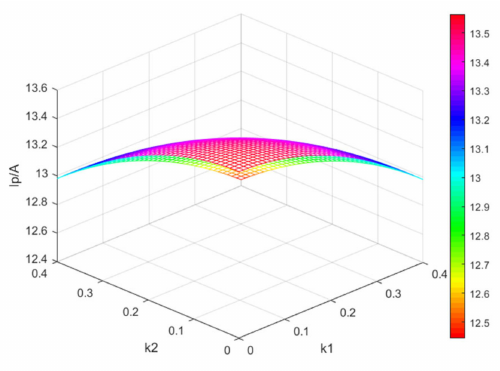
Figure 5. Curved surface plot of the track current I P changing with the coupling coefficient of load #1 and load